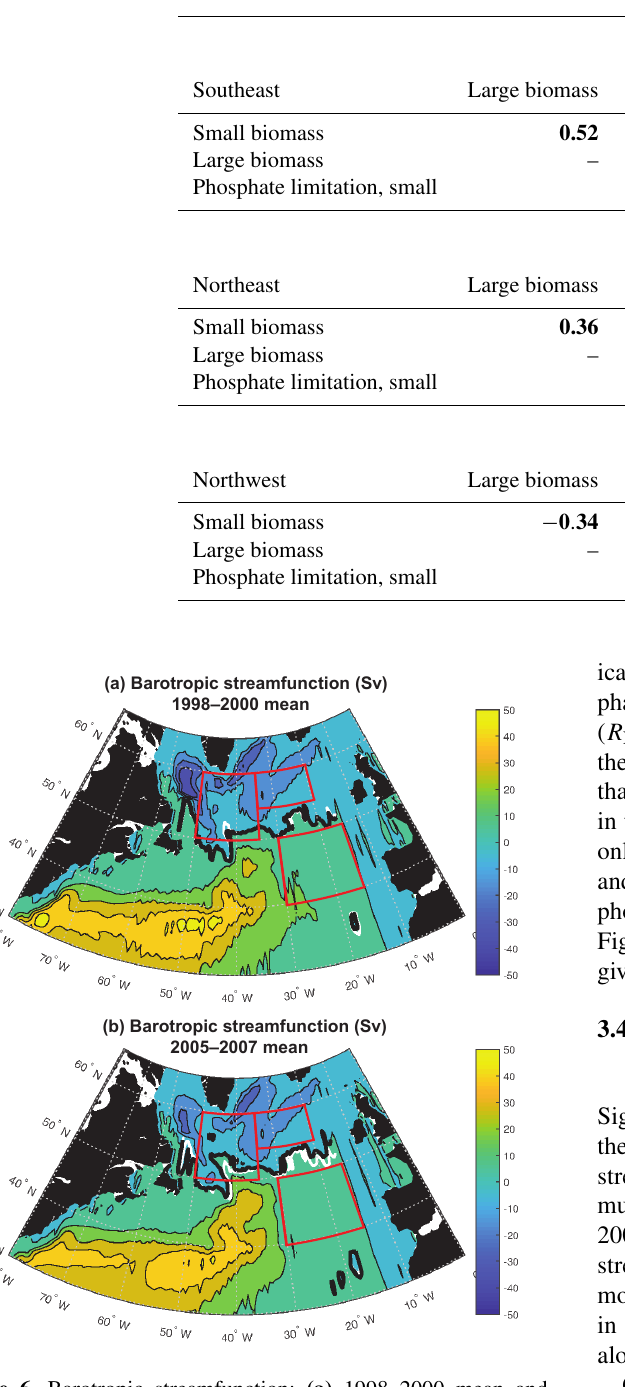
Figure 6. Barotropic streamfunction: (a) 1998–2000 mean and (b) 2005–2007 mean. The zero streamfunction contours between 55 and 15 ◦ W for each period (bold black) and for the 1998–2007 mean (white) are marked. See Fig. S5 for map of 1998–2007